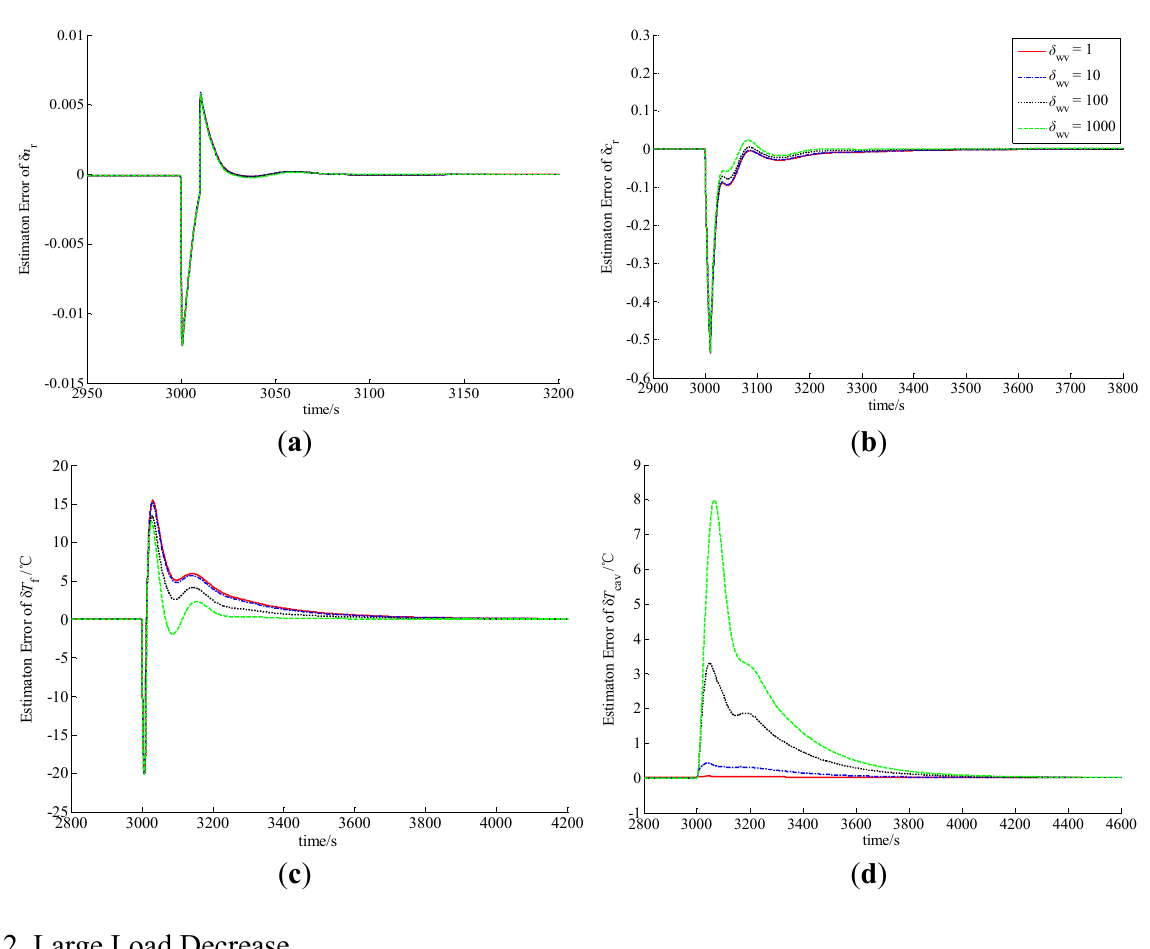
; ( b ) δ c ; ( c ) δ T and ( d ) δ T r r f